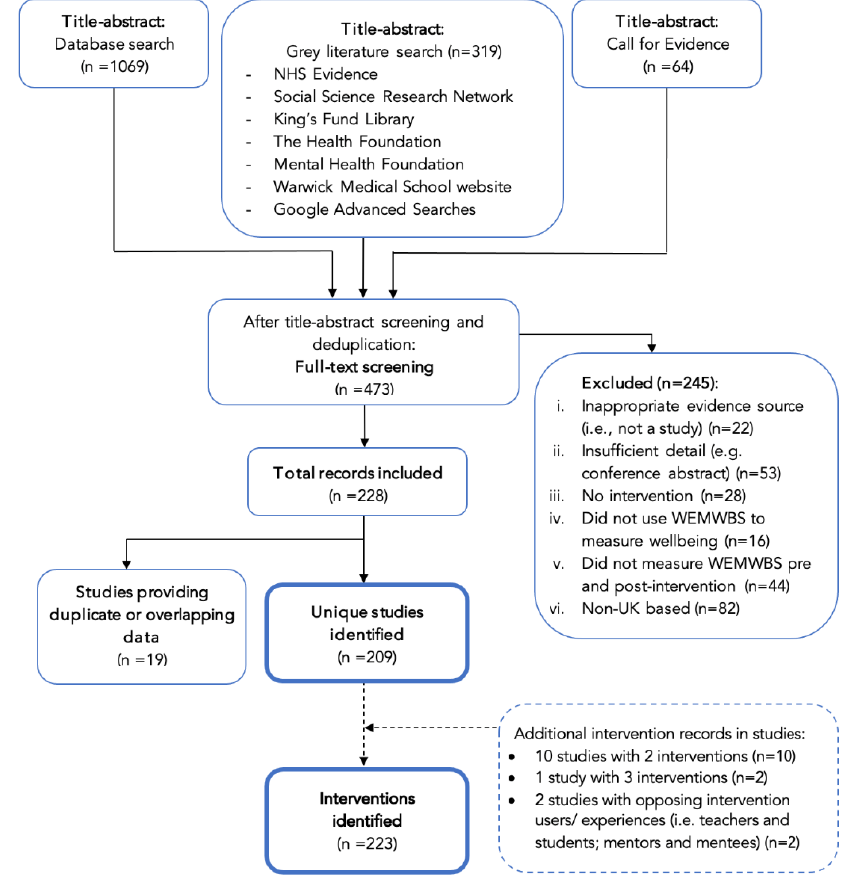
Figure 1. PRISMA diagram.